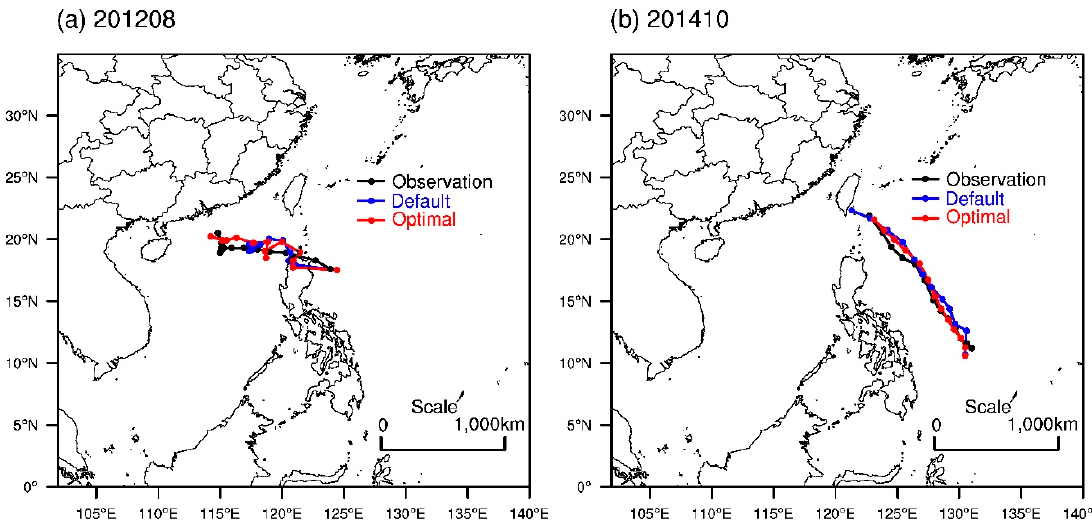
Figure 8. Track of typhoons for ( a ) Vicente (201208) and ( b ) Matmo (201410) simulated with the default and optimal scheme combination for the track simulations. and optimal scheme combination for the track